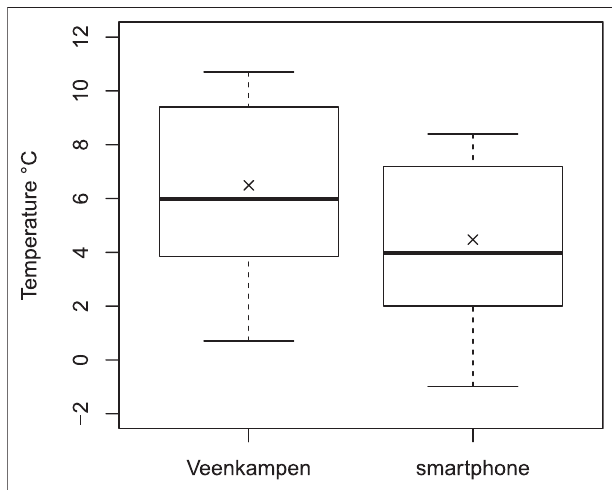
FIGURE 5 | Box-plot comparing 1.5 m height air temperature observations from the smartphone and Veenkampen meteorology station thermometer (for the autumn and winter experiments). Smartphone is placed in the same Stevenson screen. Each box ranges from 25 th to 75 th percentile (interquartile range IQR), median is denoted as the horizontal line inside the box, arithmetic mean is represented by the cross, whiskers have a maximum length of 1.5 *